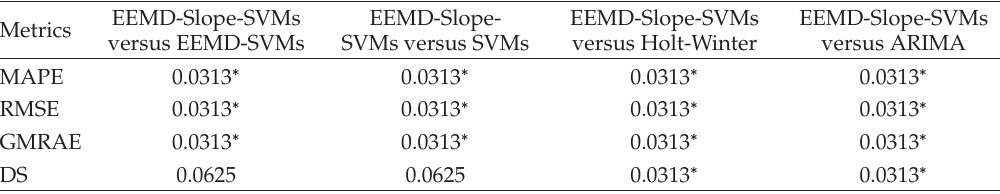
Table 3: Wilcoxon’s signed-rank test for EEMD-Slope- SVMs against the